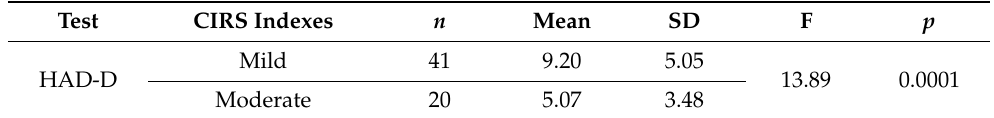
Table 4. One-way ANOVA on Depression data by CIRS indexes.